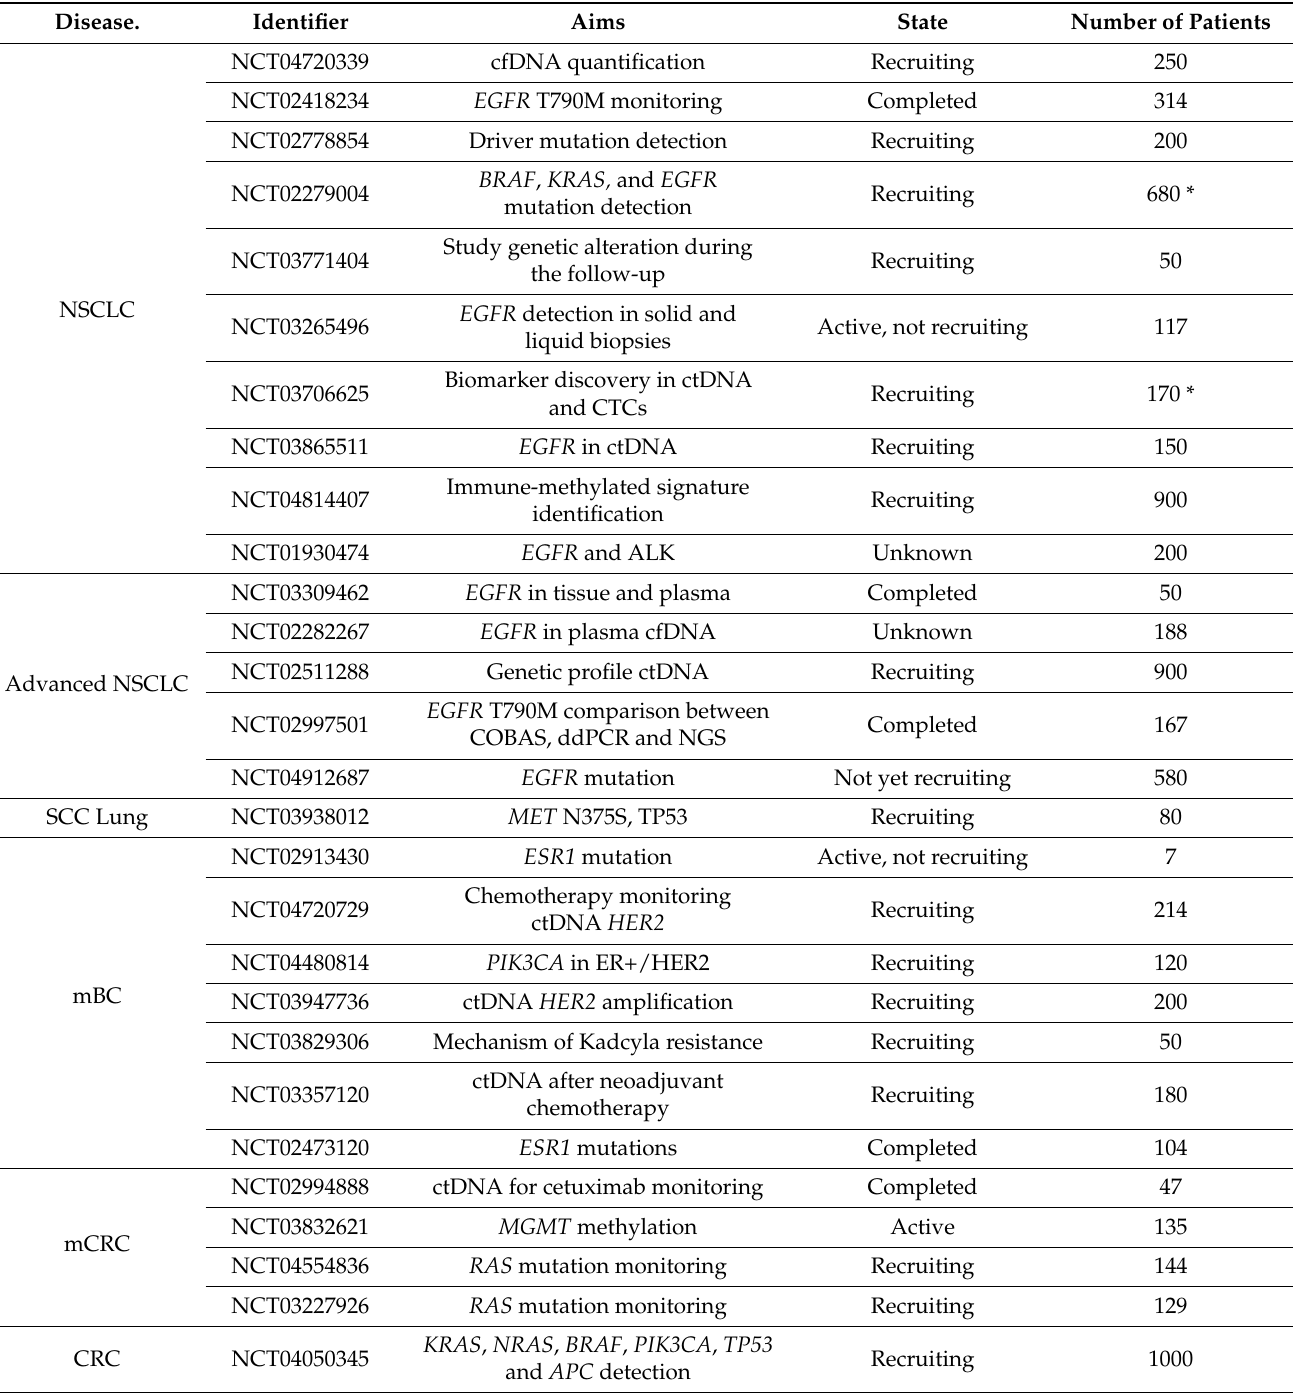
Table 5. An overview of the ongoing clinical trials in which the ddPCR technique is used for actionable biomarker detection.